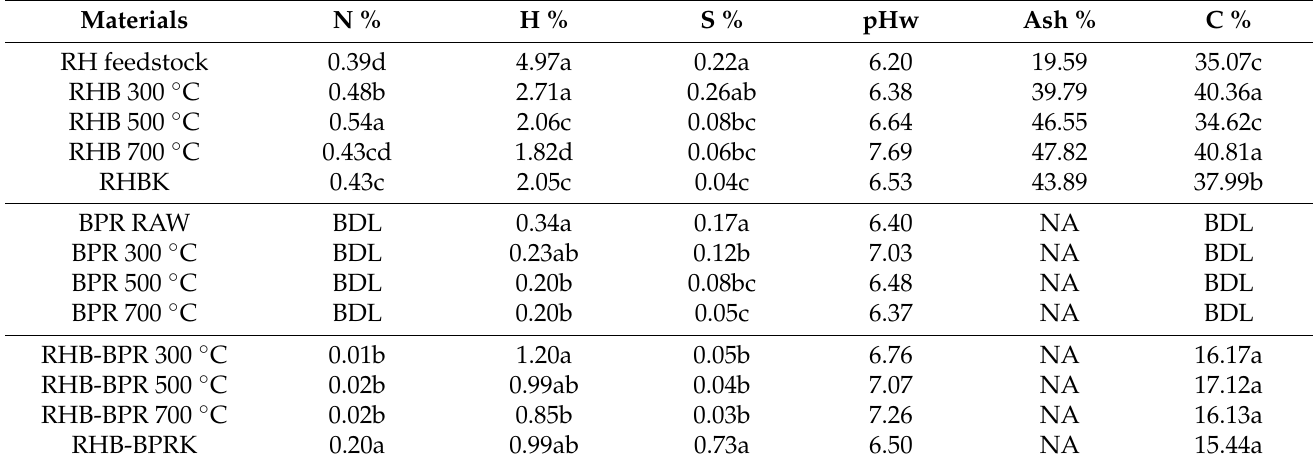
Table 1. Selected chemical properties of rice husk (RH), RHB, BPR, and RHB-BPR mixture.